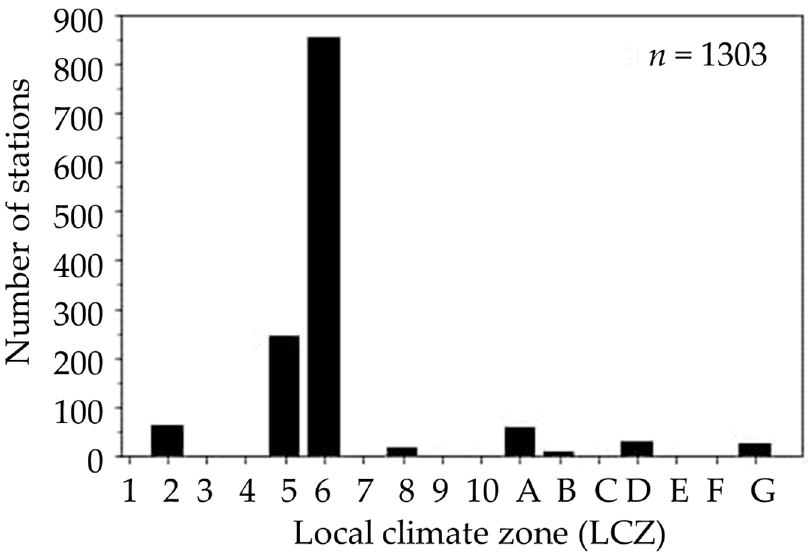
Figure 3. The number of Netatmo stations in each LCZ, throughout the study. n represents the total number of stations from which data was collected.